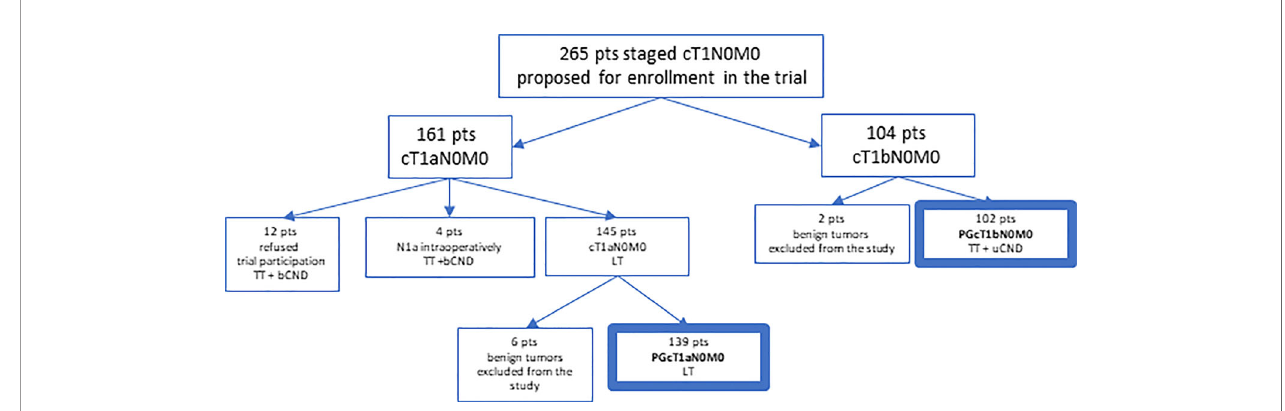
FIGURE 1 | Patient selection to the